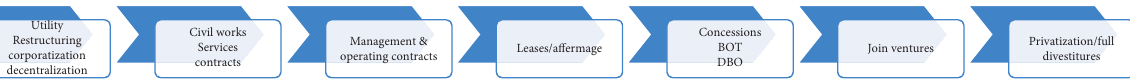
Figure 3: Share of private sector capital based on participation.